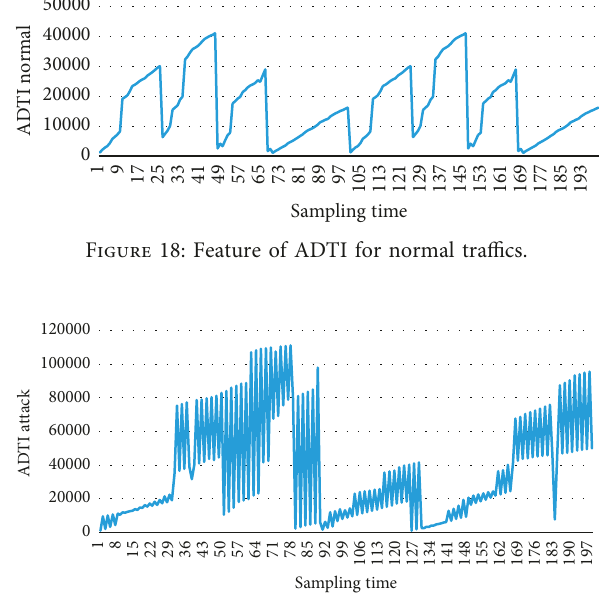
Figure 19: Feature of ADTI for attack